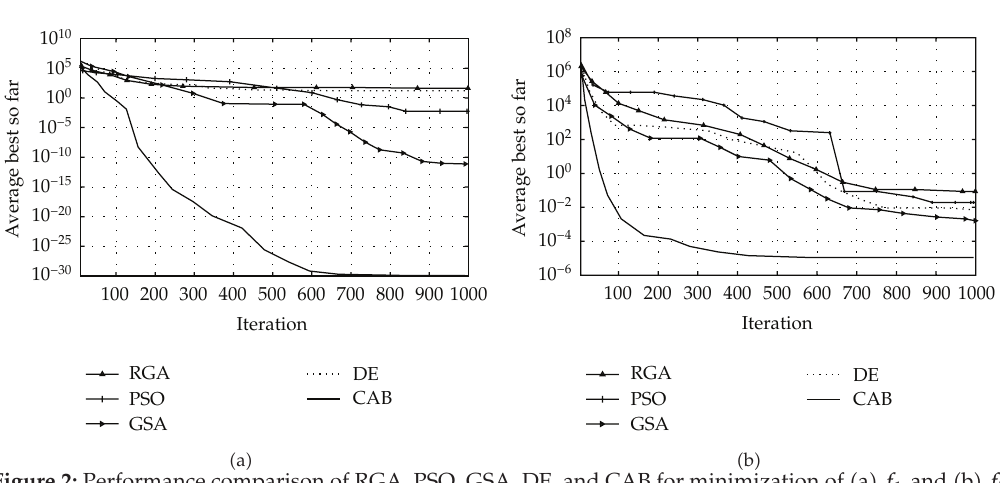
Figure 2: Performance comparison of RGA, PSO, GSA, DE, and CAB for minimization of (cid:2) a (cid:3) f 1 and (cid:2) b (cid:3) f 7 considering n (cid:8) 30. Table 3: Minimization result of benchmark functions in Table 12 with n (cid:8) 30. Maximum number of iterations (cid:8)